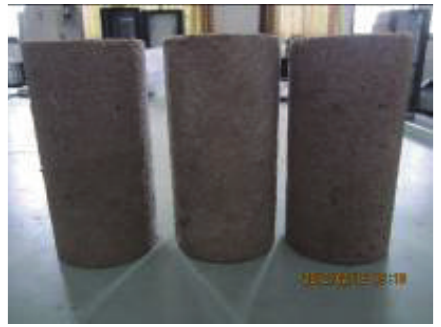
Figure 1: Mudstone samples for triaxial compression